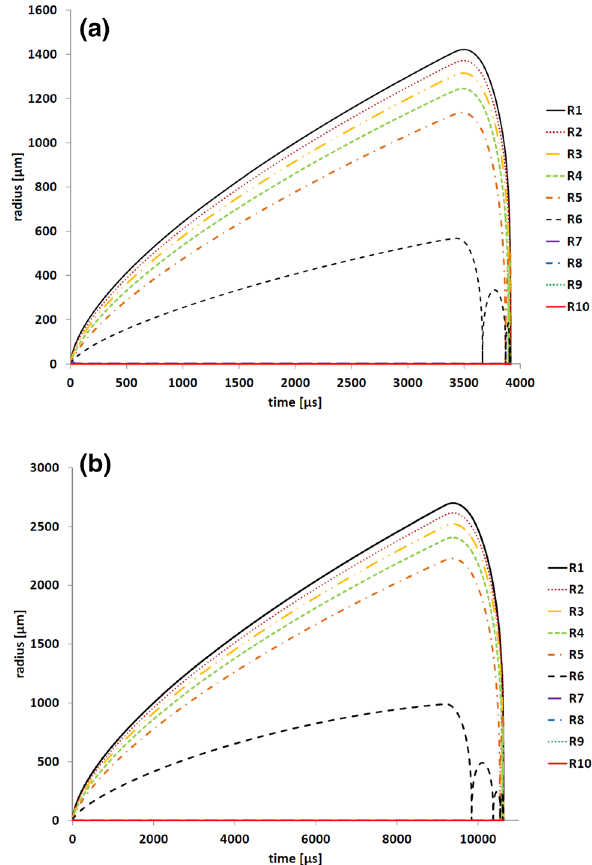
Fig. 4a Time evolution of bubbles radii for X H = 12 µm, Ω = 700 rpm and p gap and 𝜎 = 6622.91 ).